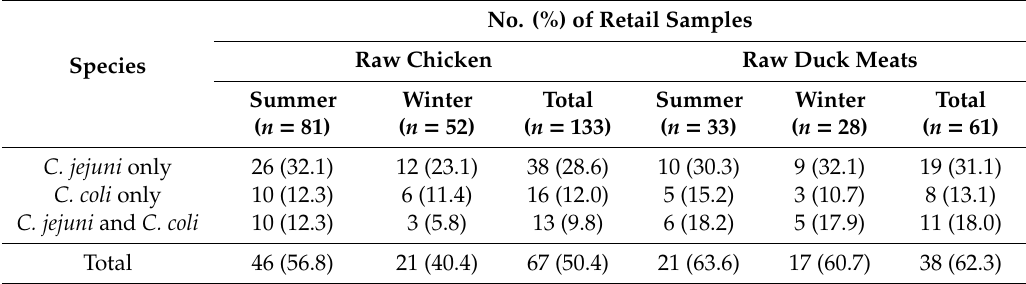
Table 1. Frequencies of Campylobacter isolation from retail raw chicken and duck